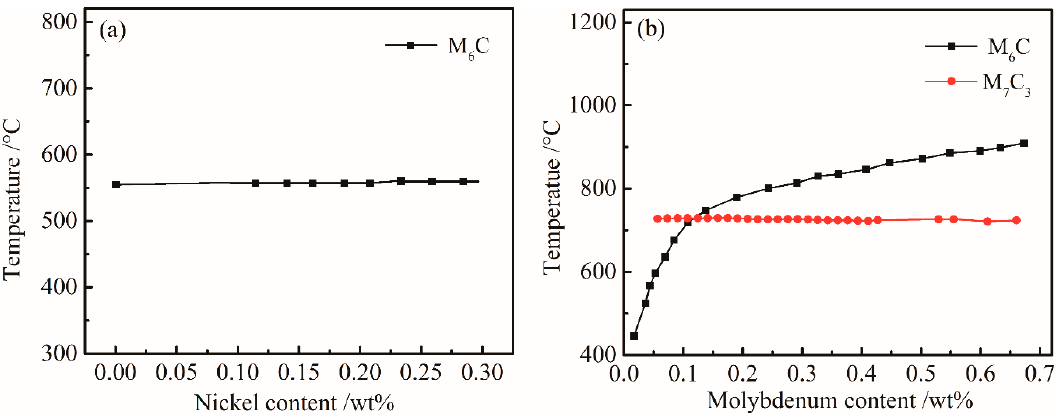
Figure 2. Influences of ( a ) Ni and ( b ) Mo content on the equilibrium phases of the bainitic